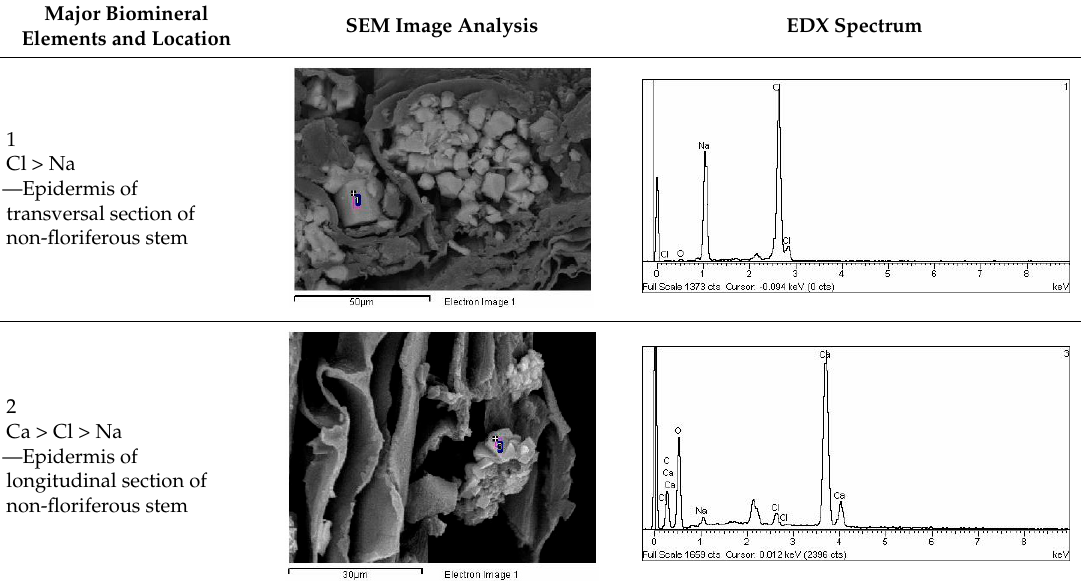
Table A1. Major biomineral elements and location of Sarcocornia pruinosa with SEM Image Analysis and EDX Spectrum.